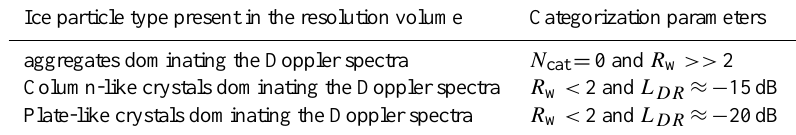
Table 2. Crystal habit categorization.